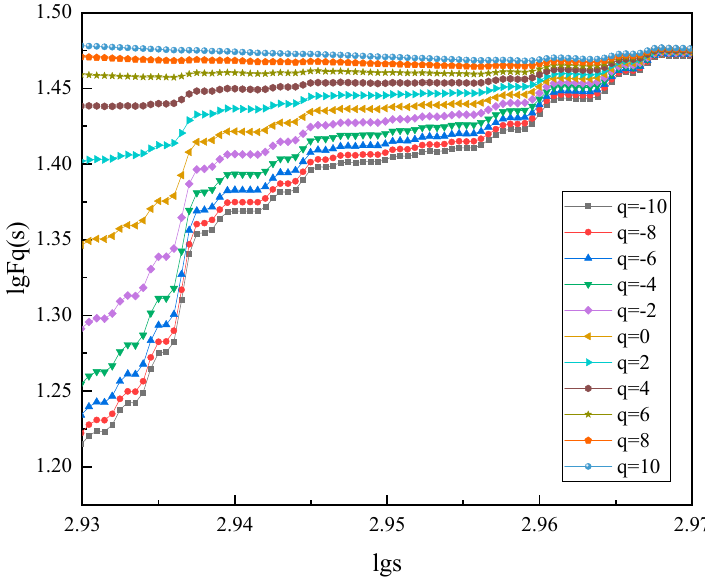
Figure 10. Double logarithm fitting trend of q-order wave function F q ( s )- s.